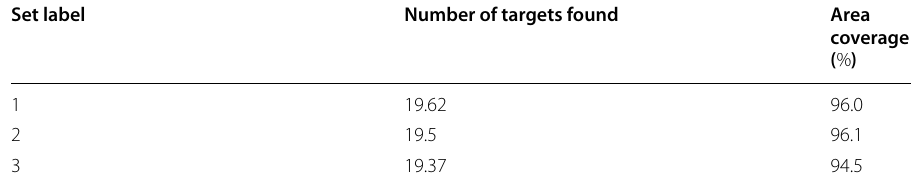
Table 4 Comparison of the CS mechanisms Set label Number of targets found